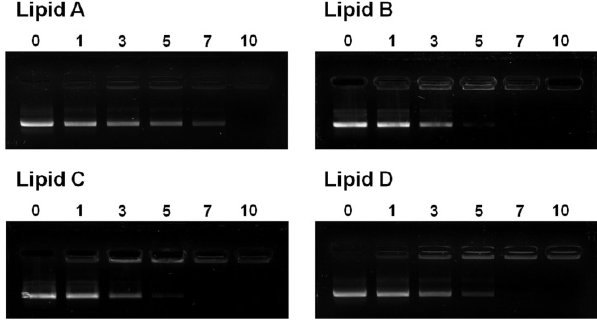
Figure 7. Gel retardation patterns of liposome/DNA complexes. Liposomes A – D were mixed with DNA at various weight ratios and then run though a 1% agarose gel. The mobility of the complexes was visualized using ethidium bromide staining. The N/P weight ratios are indicated at the top of each lane. Lanes marked “0” contained DNA alone and served as a control.